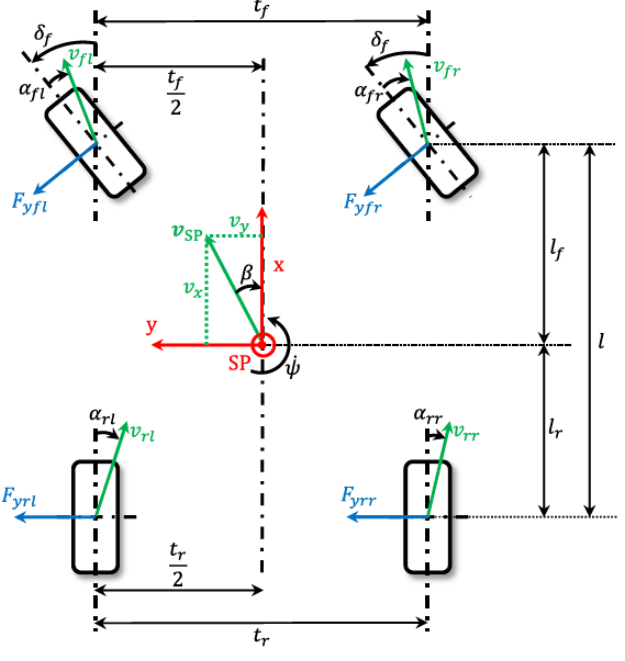
Figure 3. Two-track model